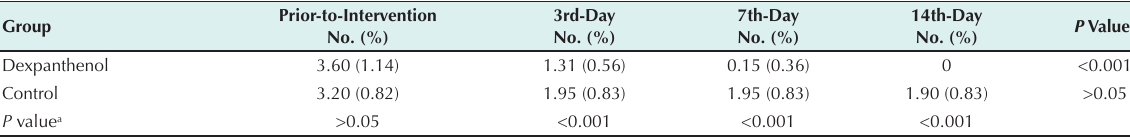
Table 3. Comparison of Pain Scores in Dexpanthenol and Control Groups at 4 Timepoints